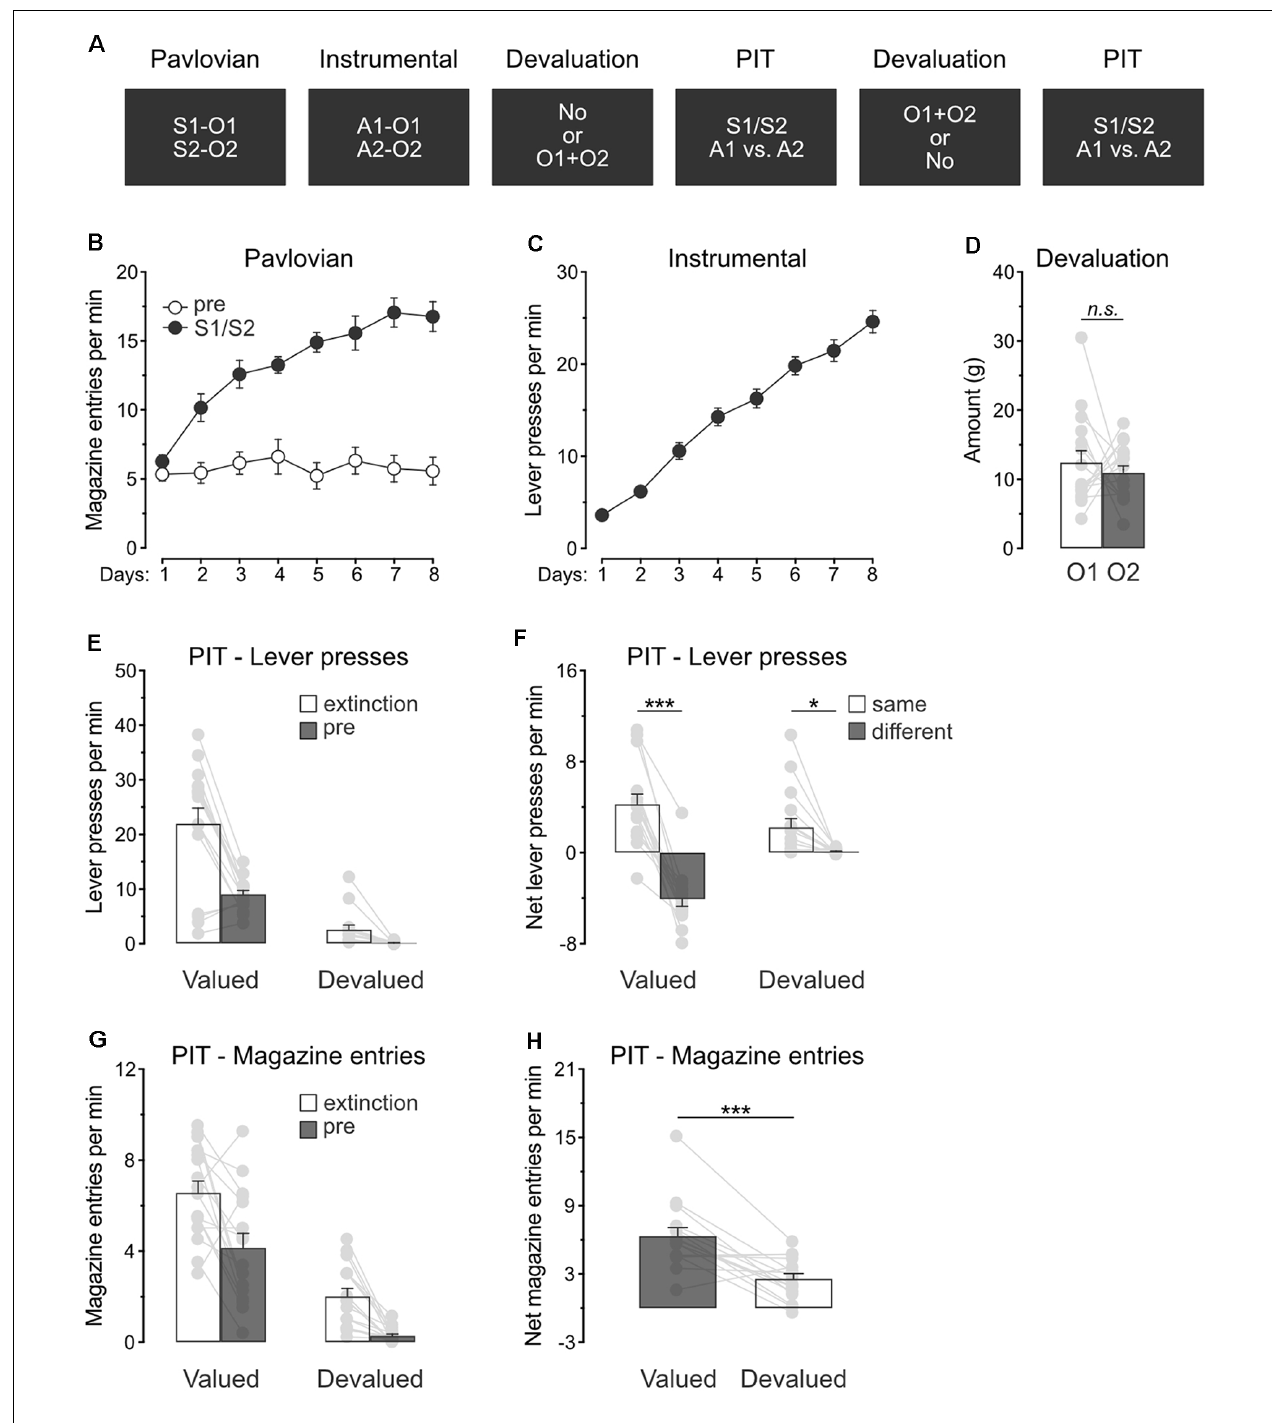
FIGURE 2 | Devaluation of all predicted outcomes spare specific PIT. (A) Design of the second experiment; S1/S2: clicker or noise stimuli (counterbalanced); O1/O2: grain pellet or sucrose solution outcomes (counterbalanced); A1/A2: left and right lever press actions. (B) All rats learned that the stimuli, S1 and S2, predicted food outcomes O1 and O2. (C) All rats learn to perform the left and right lever press actions, A1 and A2, to earn food outcomes O1 and O2. (D) During outcome devaluation via sensory-specific satiety, rats consumed an equivalent amount of O1 and O2. (E) Outcome devaluation reduced lever press responding during the extinction and baseline (pre) period of the specific PIT test. (F) Outcome devaluation spared specific PIT. (G) Outcome devaluation reduced magazine entries during the extinction and baseline (pre) period of the specific PIT test. (H) Although magazine entries were reduced after outcome devaluation, rats showed substantial levels of magazine entries in the presence of the stimuli. Data are shown as mean ± SEM. Asterisks denote significant effect (* p < 0.05; *** p < 0.001). n.s., nonsignificant.